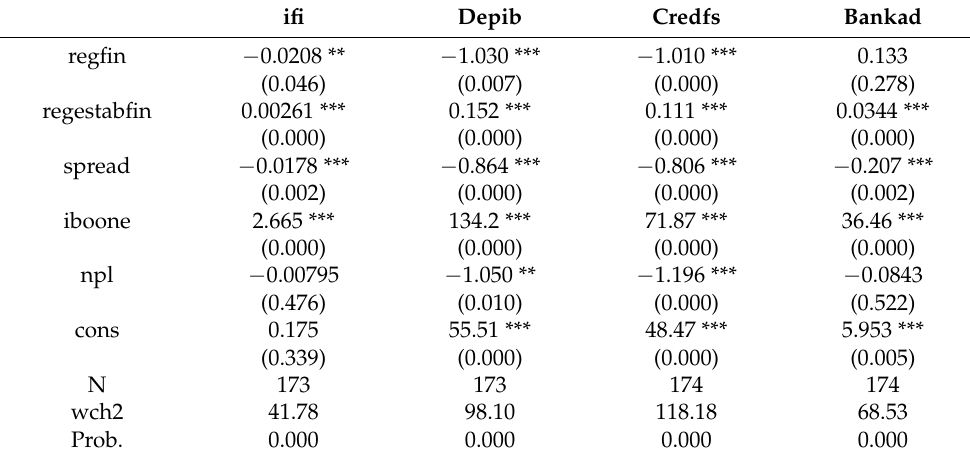
Table 8. Complete